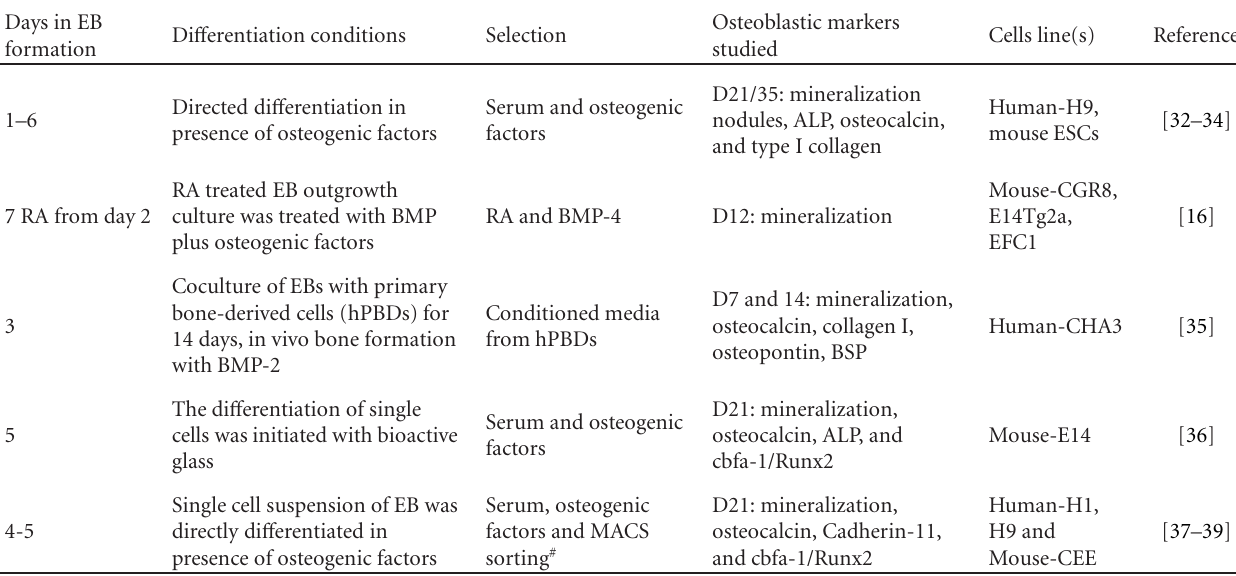
Table 3: In vitro models for direct di ff erentiation of embryonic stem cells into osteogenic lineages. Days in